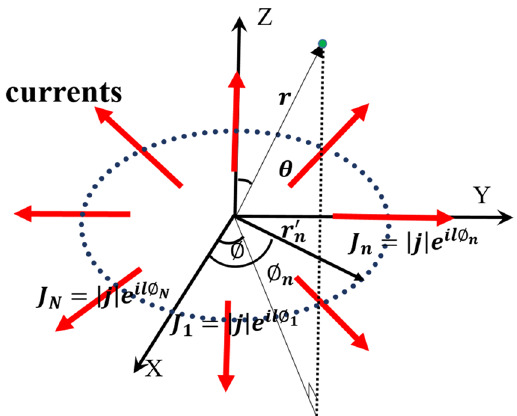
Figure 1. Geometric arrangement of discrete currents on the